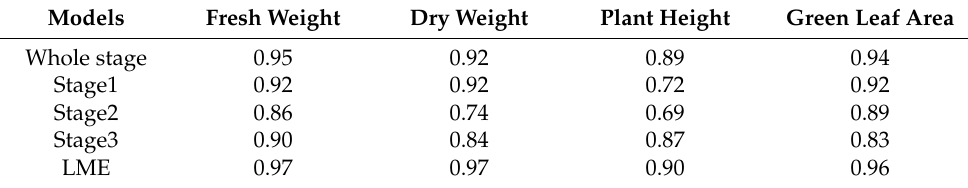
Table 6. Different model correction R 2